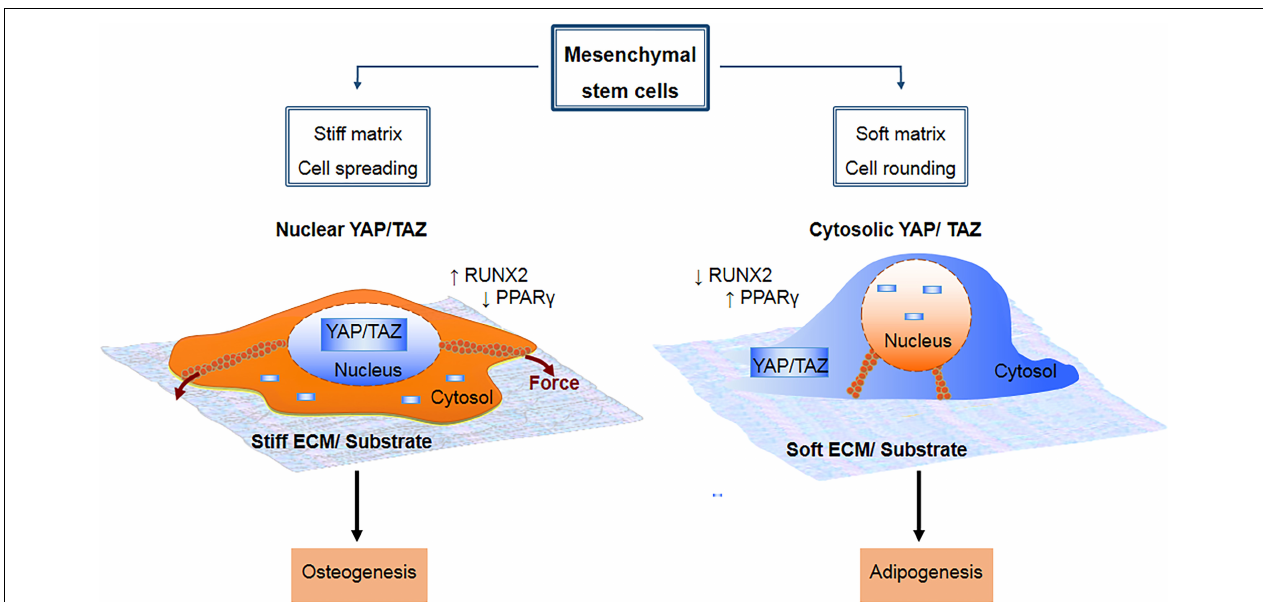
FIGURE 3 | Mesenchymal stem cell lineage fate is known to be influenced by mechanical cue-induced localization and activation of YAP/TAZ. On a stiff substrate, there is increased integrin clustering and formation of focal adhesions, which in turn enhances F-actin polymerization and formation of stress fibers. This cause the cell to spread out over a larger surface area due to increased torsional forces within the stress fibers, and promotes cytosolic to nuclear translocation of YAP/TAZ, which drives osteogenesis by upregulating RUNX2 and downregulating PPAR γ . By contrast, a soft substrate is non-conducive to formation of focal adhesions and stress fibers, causing the cell to adopt a more rounded morphology with less spreading area. This in turn promotes sequestration of YAP/TAZ within the cytosol, which drives adipogenesis by upregulating PPAR γ and downregulating RUNX2.